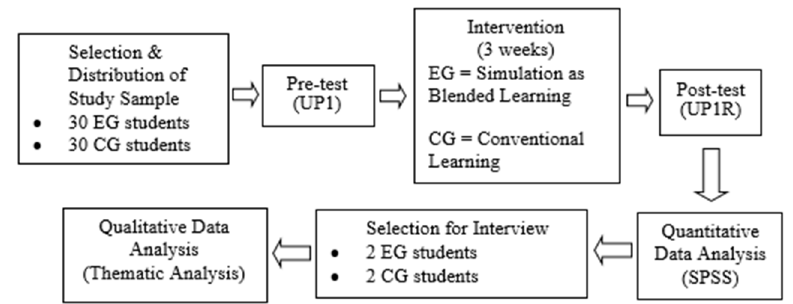
Figure 1. This is a figure of researchers’ exploratory research design in this